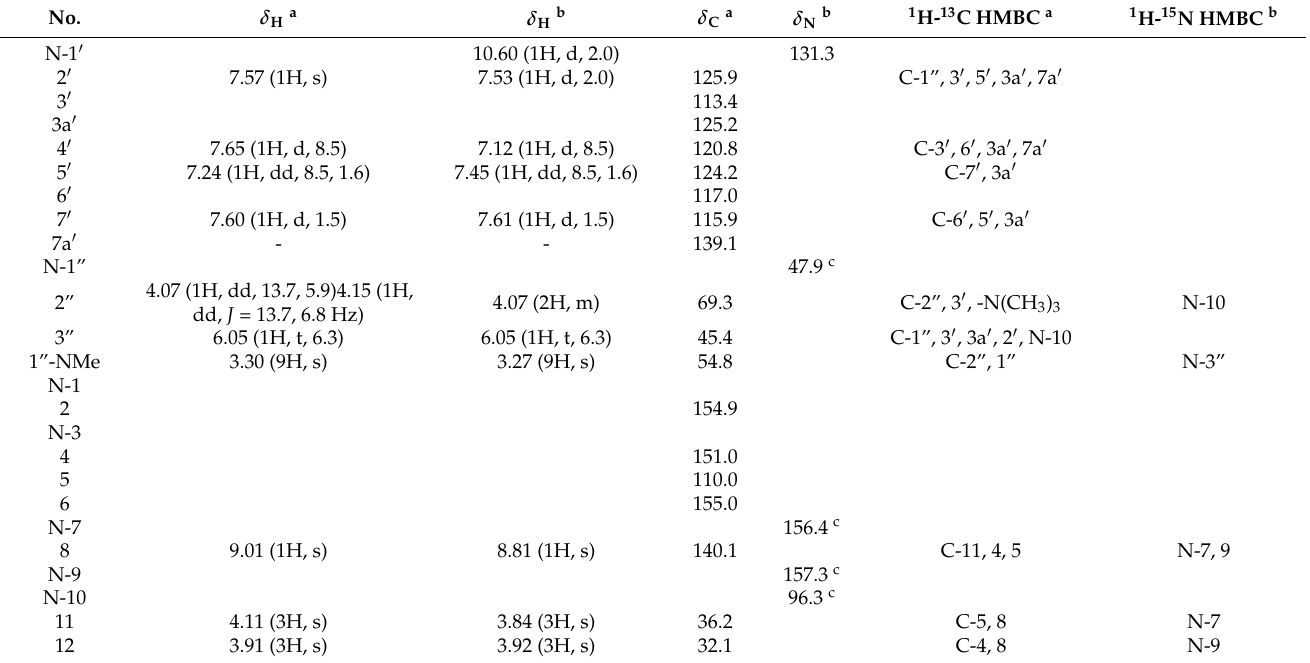
Table 1. 1 H NMR (600 MHz) and 13 C NMR (150 MHz) spectroscopic data for geobarrettin D ( 1 ).